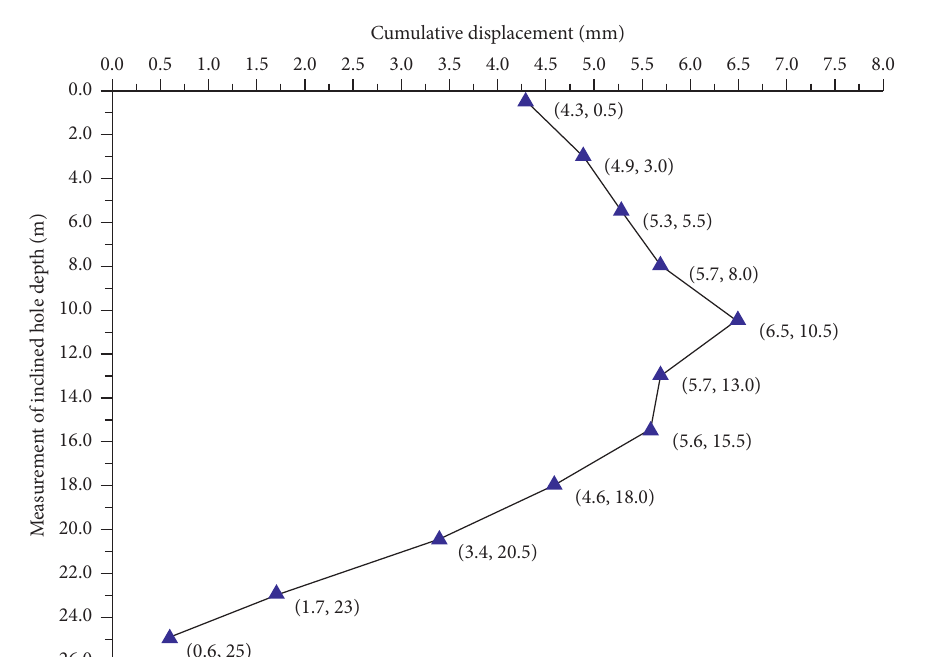
Figure 29: Inclinometer data when the foundation pit is excavated to the